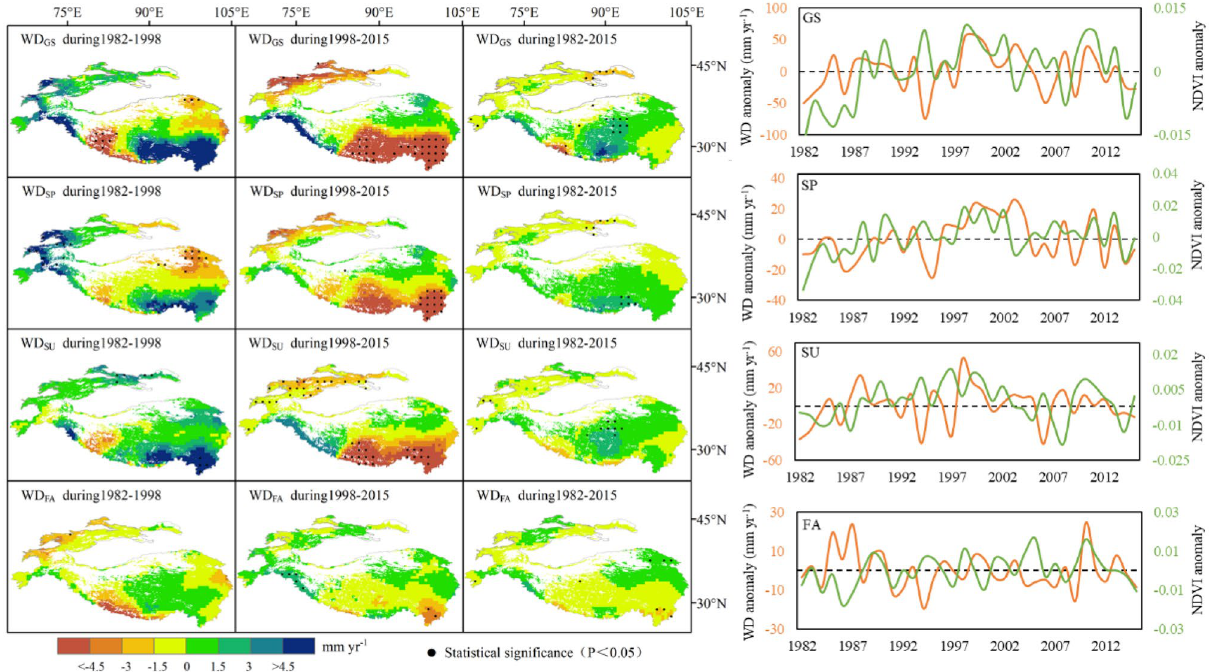
Figure 5. Spatial distribution of trends and inter-annual dynamics of water deficit for growing seasons (WD GS ), spring (WD SP ), summer (WD SU ) and fall (WD FA ) during 1982–2015 in HMA. Note that regions demarcated by black dots indicate trend values that are statistically significant (p < 0.05) (Generated by ArcGIS 10.3, URL: http:// www. esri. com/ softw are/ arcgis/ arcgis- for- deskt op, and Matlab R2013a, URL: http:// cn. mathw orks. com/ produ cts/ when the temperature change trend leapt and the precipitation change trend reversed. Prior to the jump in temperature, warming and wetting corresponded to vegetation greening in northwest, south-central and eastern HMA. However, after the jump in temperature, warming and drying corresponded to vegetation browning in northwest, central and southern HMA, while cooling and wetting corresponded to vegetation greening in the Qilian Mountains. On a seasonal scale, after 1998, the amount of browning in spring was low in central HMA and high in the northwest and southeast HMA, which is the same as the warming and drought trend. Prior to 1998, summer precipitation in the eastern part of HMA showed an increasing tendency. At the same time, the spatial distribu- tion of temperature and NDVI variability was comparable. After 1998, the temperature in the northeastern part of HMA charted a downward trend, while precipitation increased and NDVI increased. Temperature in the southeast and Tianshans area increased, precipitation decreased, and NDVI decreased. Prior to 1998, in fall, the warming and drying in the Tianshans corresponded to vegetation greening, the cool- ing and drying of the TP corresponded to vegetation browning. After 1998, however, the warming and wetting of the Tianshans corresponded to the browning of vegetation, the warming and wetting of the TP corresponded to the greening of vegetation. Therefore, although temperature in spring and fall had a greater effect on plant growth, a jump in temperature made precipitation the key factor restricting vegetation growth. This shows that the dynamic changes of vegetation under global climate change are not simply dominated by temperature or precipitation, but are influenced by both of these factors at different time scales. Coupling relationship between NDVI and water deficit. The water deficit can comprehensively represent the combination of regional temperature and water (Fig. 5). During our study period, the water deficit shows an increasing trend, accounting for 52.9% of HMA, with an average rate of 0.127 mm yr −1 . This rate is consistent with the proportion and distribution of greening pixels (67.4%), even though the precipitation variability was about 5 times the rate of water deficit. Prior to 1998, the water deficit in HMA (61.9%) showed an increasing trend, with an average rate of 1.341 mm yr −1 . However, after 1998, 70.1% of HMA experienced a decreasing water deficit trend at an average rate of − 2.653 mm yr −1 . On a long-term scale, the continuous warming in the past 30 years has aggravated the regional water cycle. Taking 1998 as the boundary, the land evapotranspiration caused by warming has far exceeded precipitation, reversing the trend of regional water deficit changes. For the period under study, 57.1% and 57.3% of the pixels exhibited an increasing trend of water deficit during spring and summer, with an average rate of change of 0.144 mm yr −1 and 0.096 mm yr −1 , respectively. The corresponding green pixels were 65.6% and 56.8%, respec- tively. Before 1998, 52.2% and 85.2% of HMA showed an increasing water deficit trend, with an average change rate of 1.065 mm yr −1 and 1.075 mm yr −1 in spring and summer, respectively. After 1998, 72.8% and 75.0% of